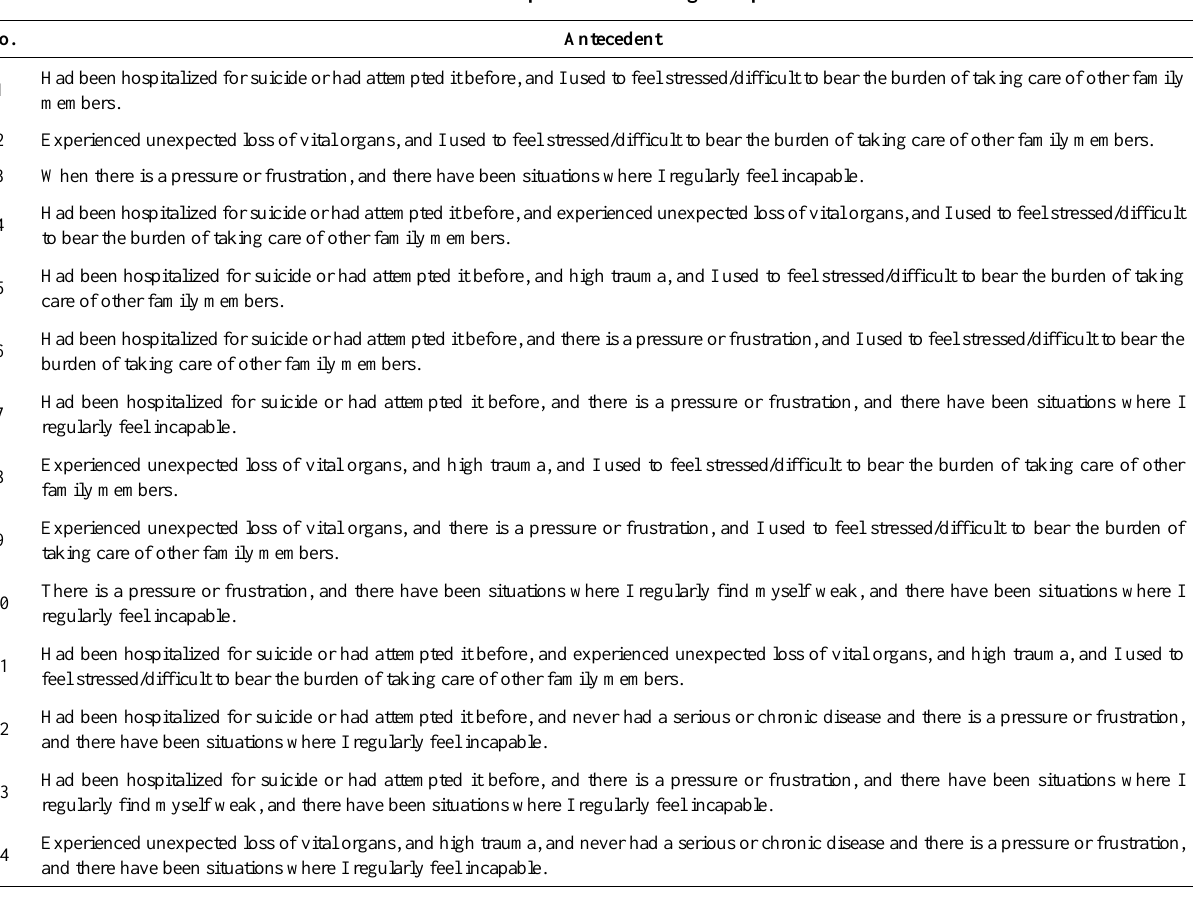
Table 2. Associated patterns resulting in